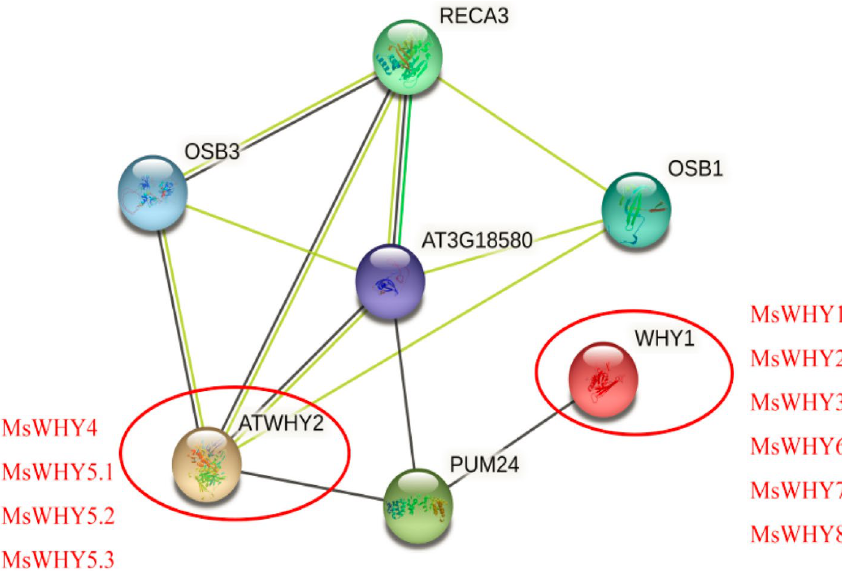
Figure 6. Protein–protein interaction analysis of MsWHYs proteins. Protein–protein interaction network produced by STRING, where each node represents a protein and each edge represent an interaction.